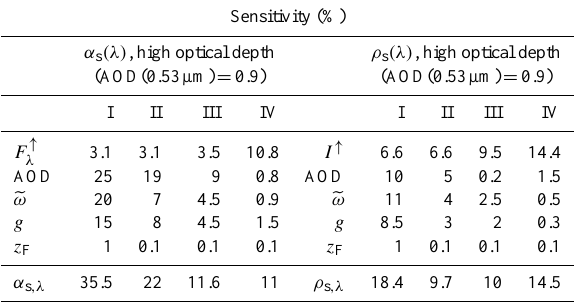
Table 2. Relative uncertainties of the different error sources and un- certainty (one sigma) of surface albedo and reflectance after Gaus- sian error propagation for high aerosol particle optical depth. The roman numerals I–IV indicate the wavelength ranges. I: 0.4–0.6µm,